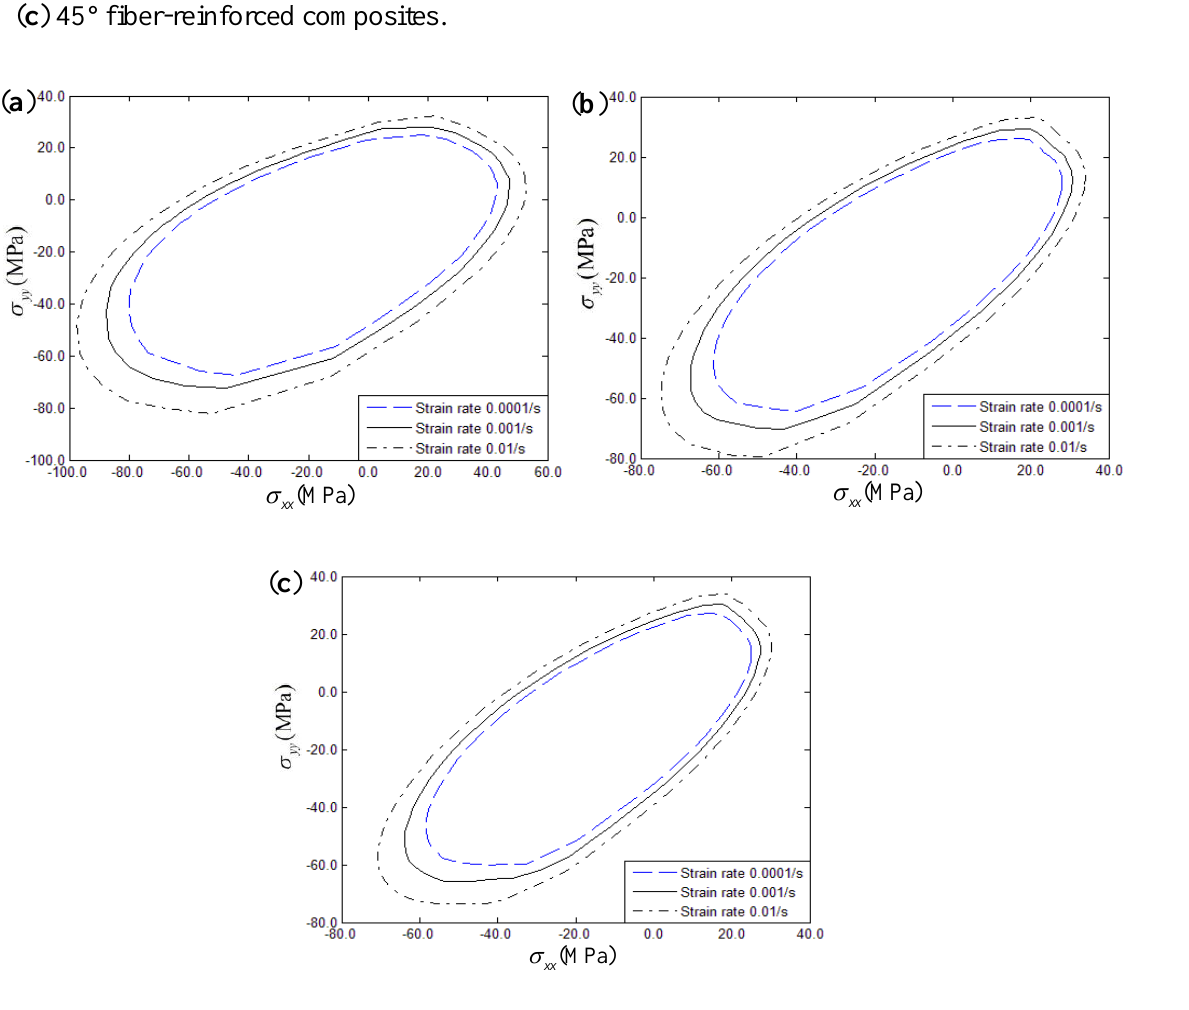
Figure 12. Strain rate influence on yield surface